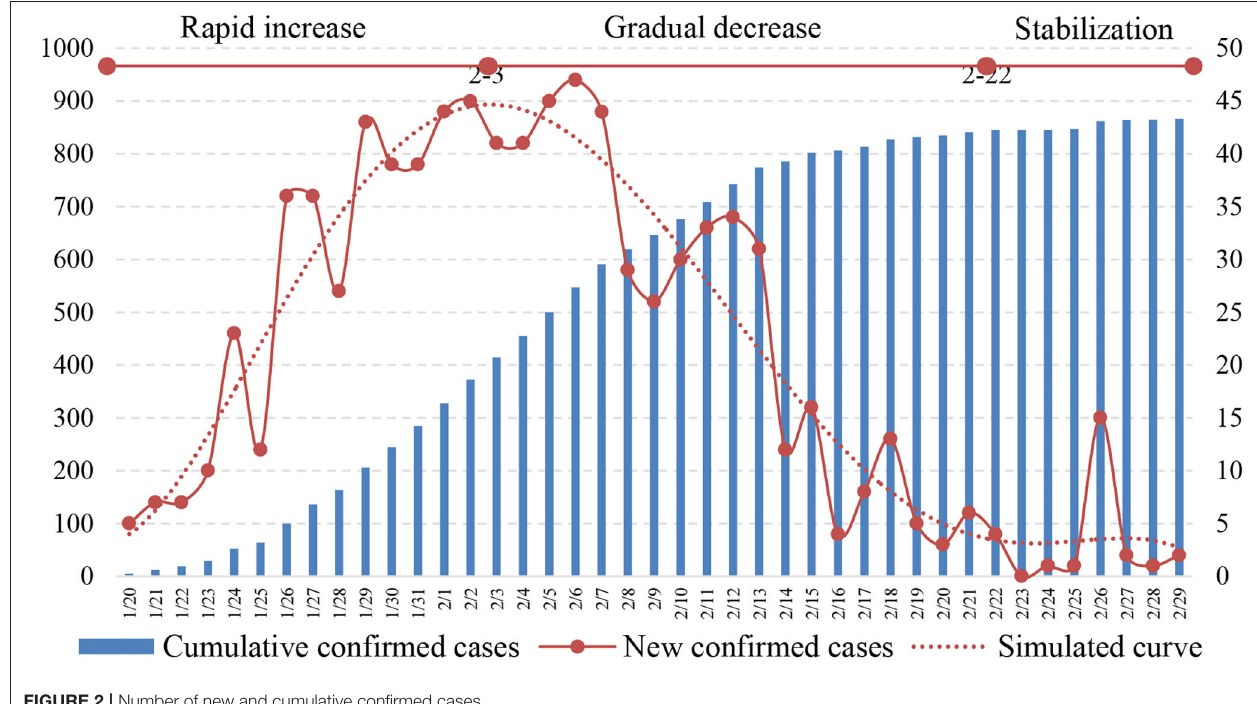
FIGURE 2 | Number of new and cumulative confirmed cases.